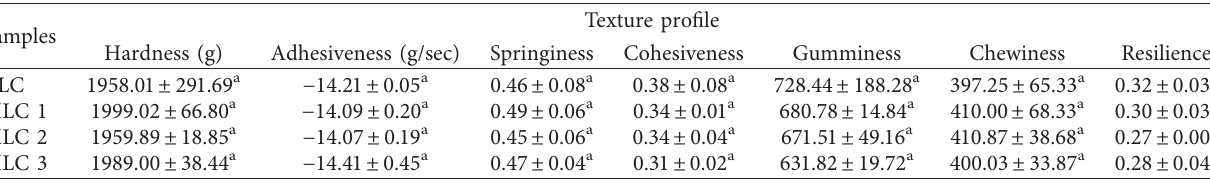
Table 12: Texture profile of layer chicken meat obtained from a genuine supplier and three different